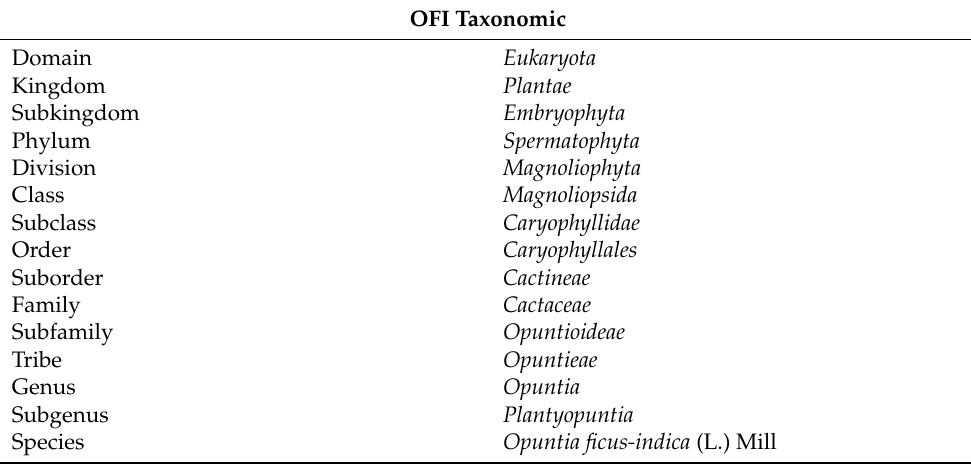
Table 1. Taxonomic classification of Opuntia ficus-indica (L.) Mill